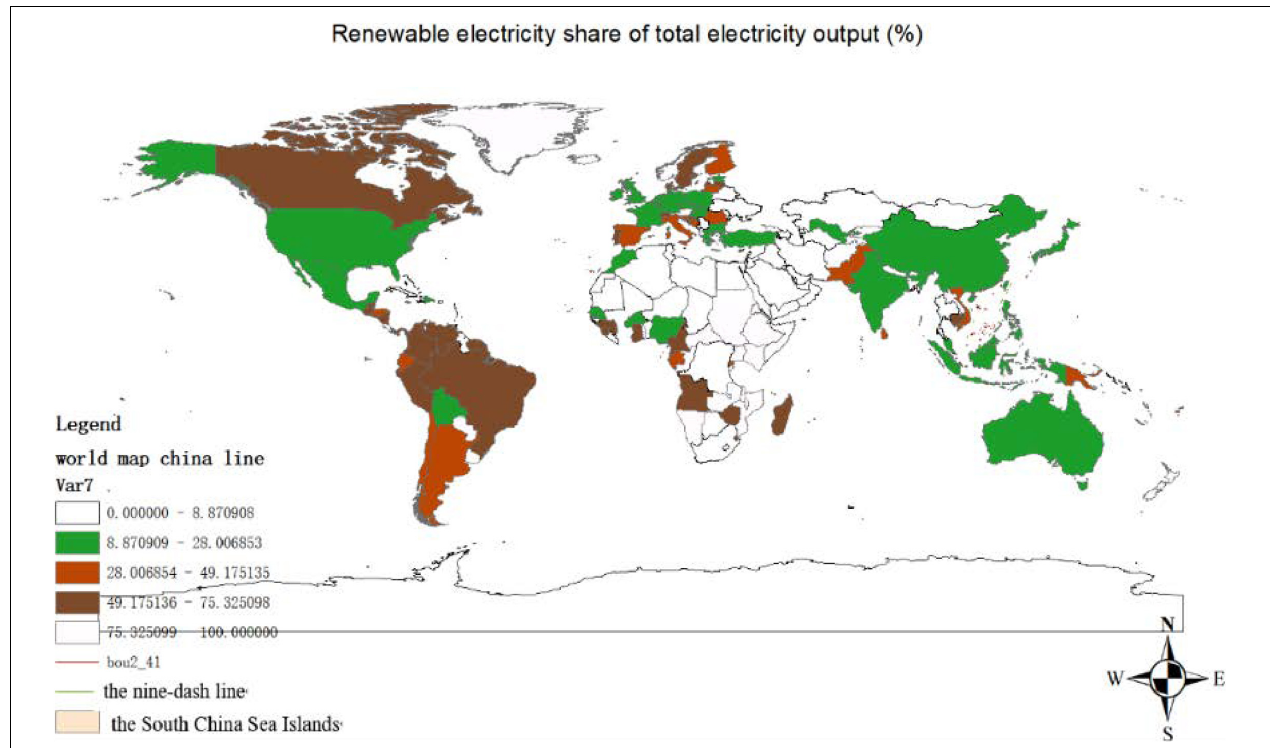
FIGURE 4 | RERs electricity share of total electricity output in countries of the world in 2014 (%).